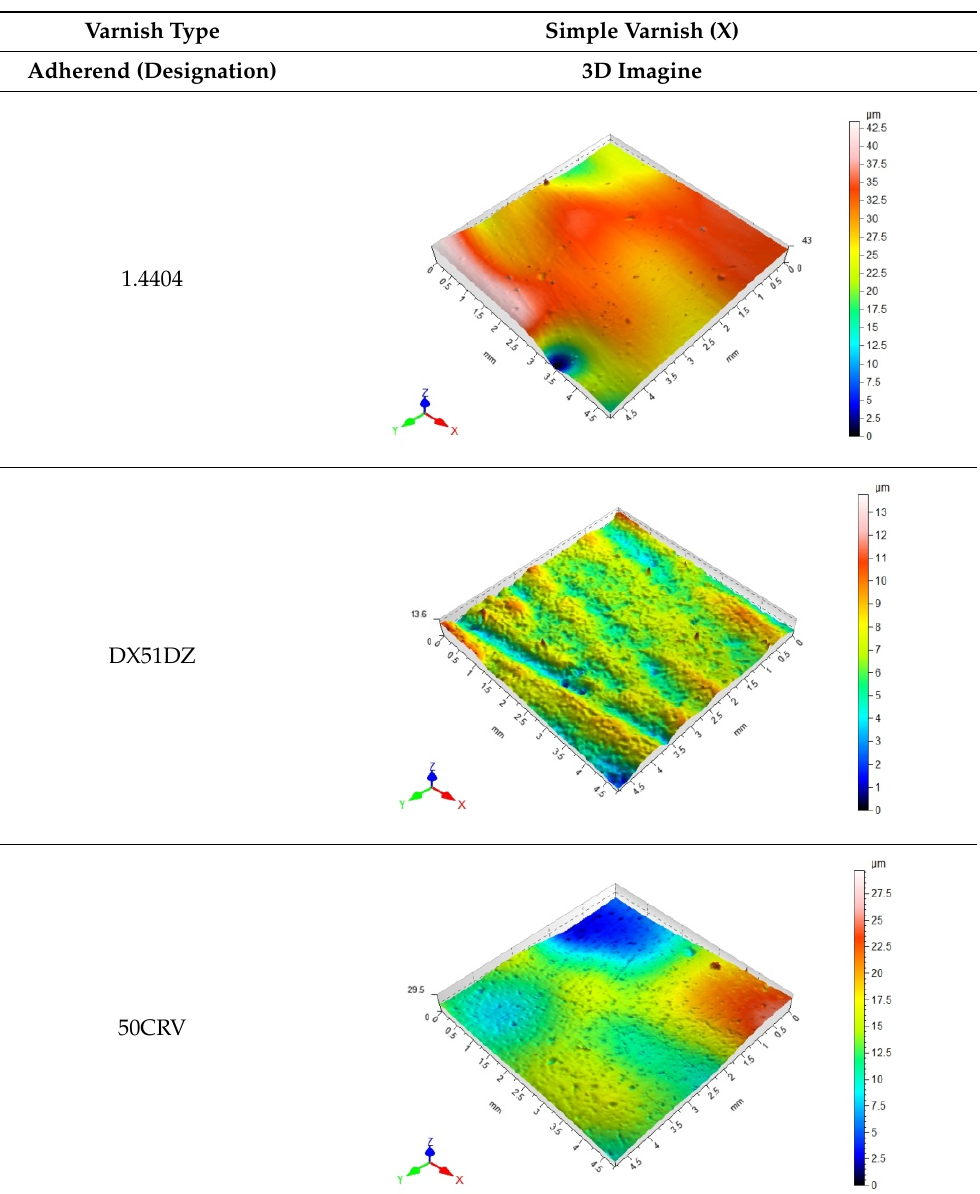
Table 12. 3D surface topography for spatial structure adherends with simple varnish (X).